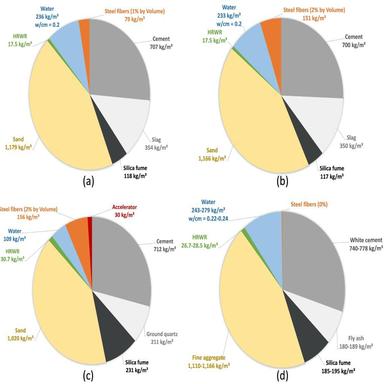
Mixing proportions of: (a, b) ABC-UTC NP-UHPC baseline mix with 1% and 2% steel fibers, (c) typical commercial UHPC mix reported in , and (d) FHWA NP-UHPC mixes reported in .